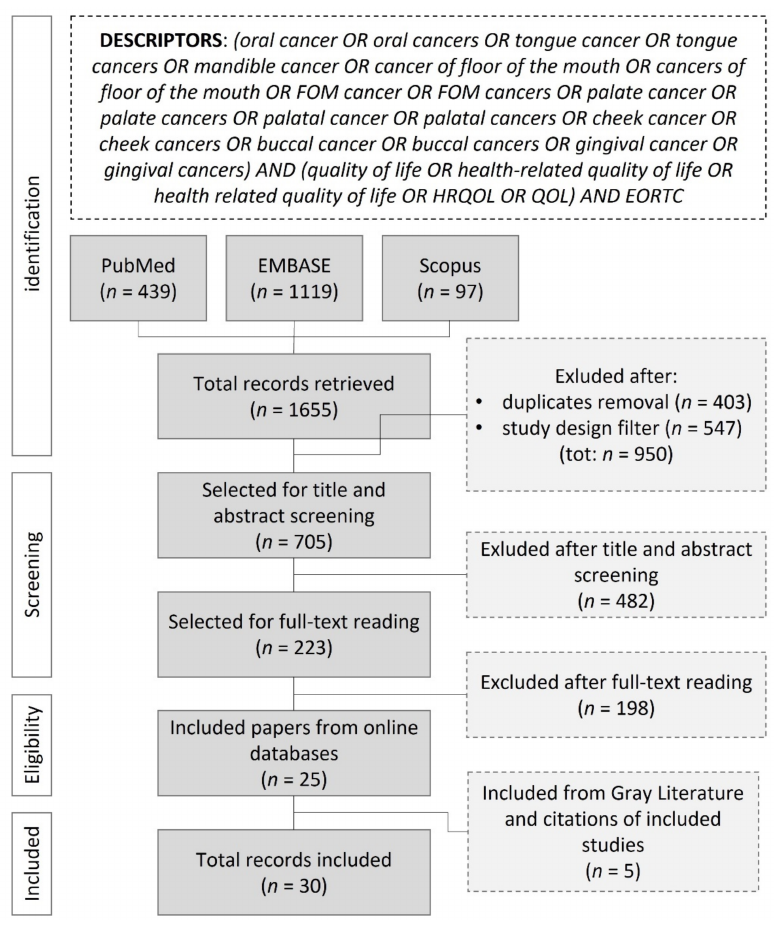
Figure 1. PRISMA search flow